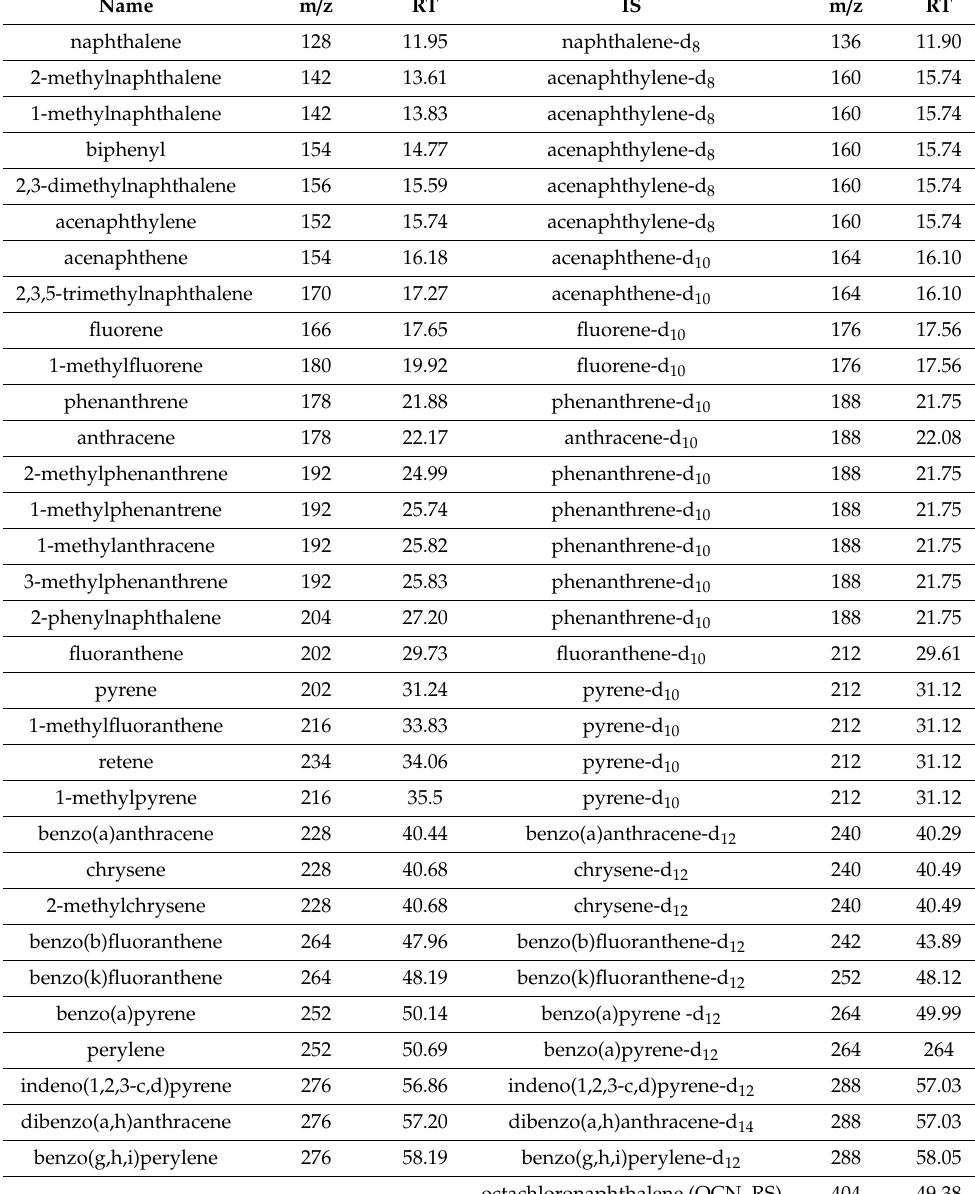
Table A1. Transitions and retention times of PAHs, alkylated PAHs, deuterium labeled internal standards (IS) and recovery standard (RS) used. Analysis was performed, using electron impact